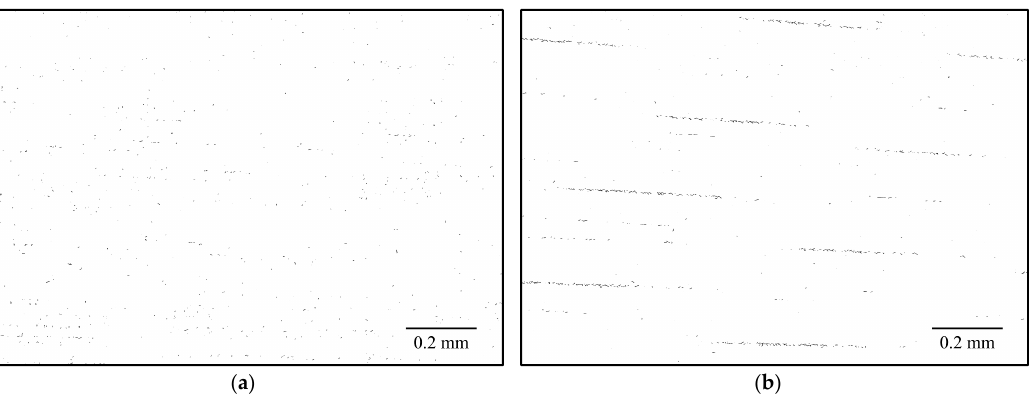
Figure 10. Micrograph of the MRF wedge surface after etching: ( a ) sample with low SSD ( v c = 54 m/s; c max = 4.6 µm); ( b ) sample with larger SSD ( v c = 30 m/s; c max = 6.8 µm).